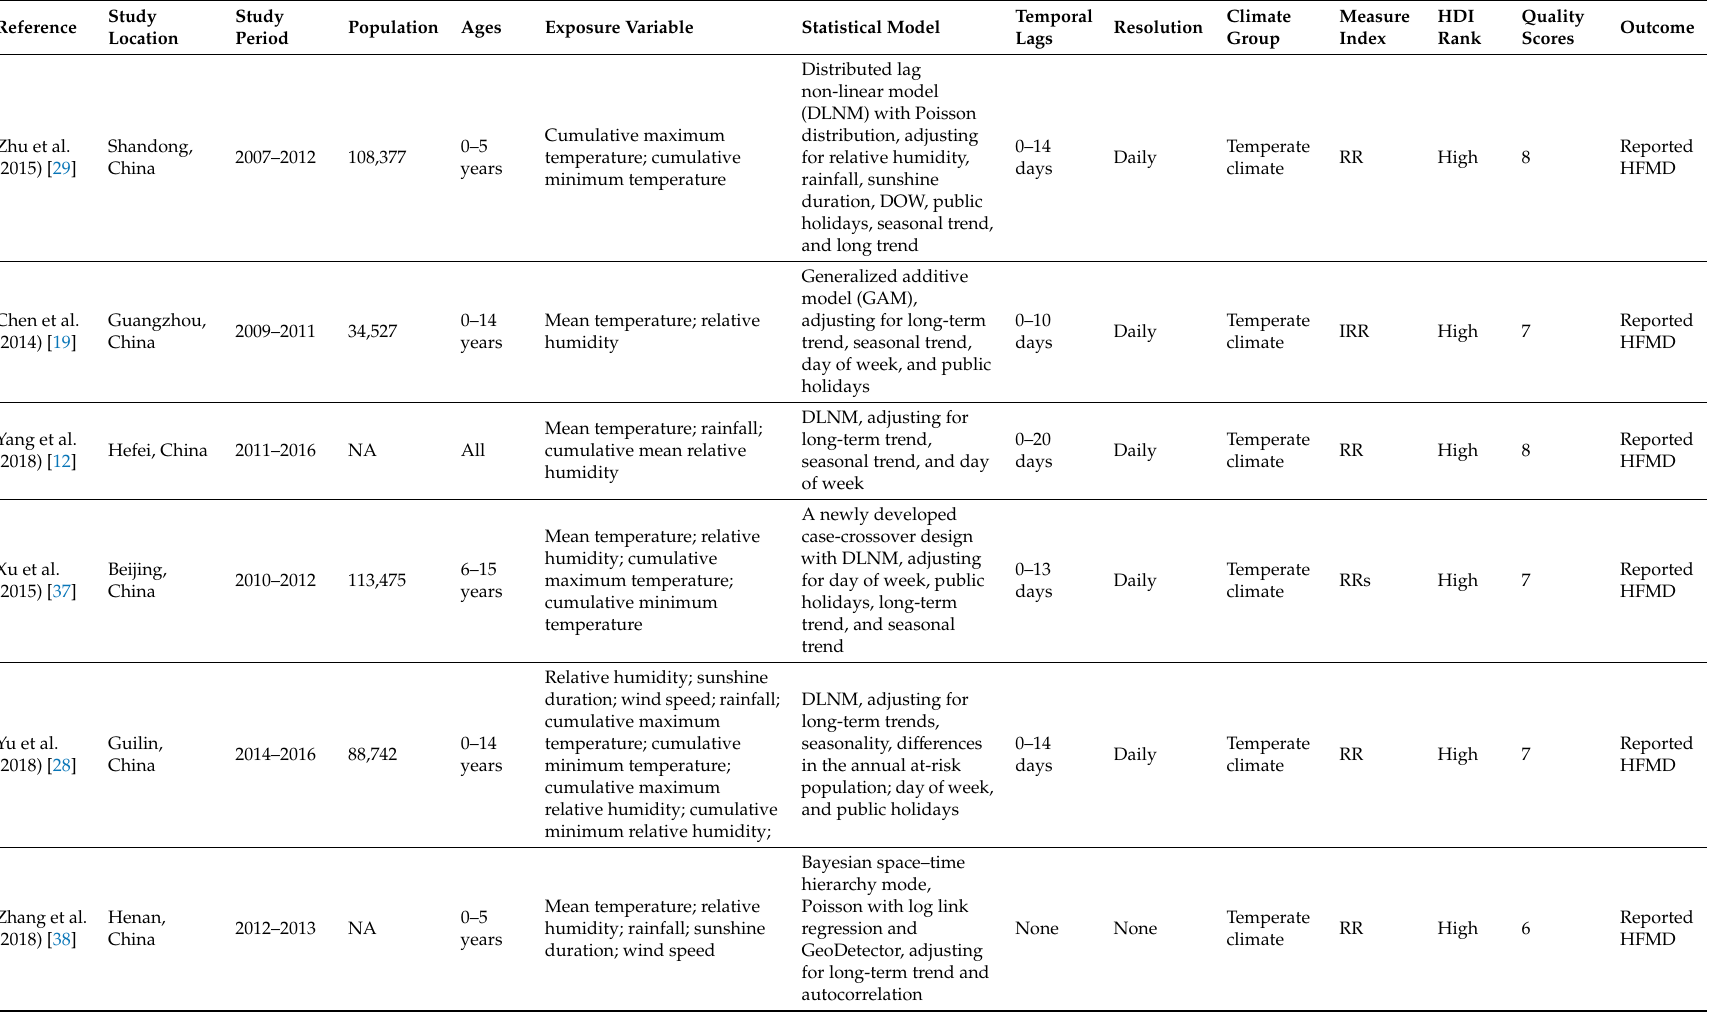
Table 1. Characteristics of the included studies on the associations between meteorological factors and the risk of